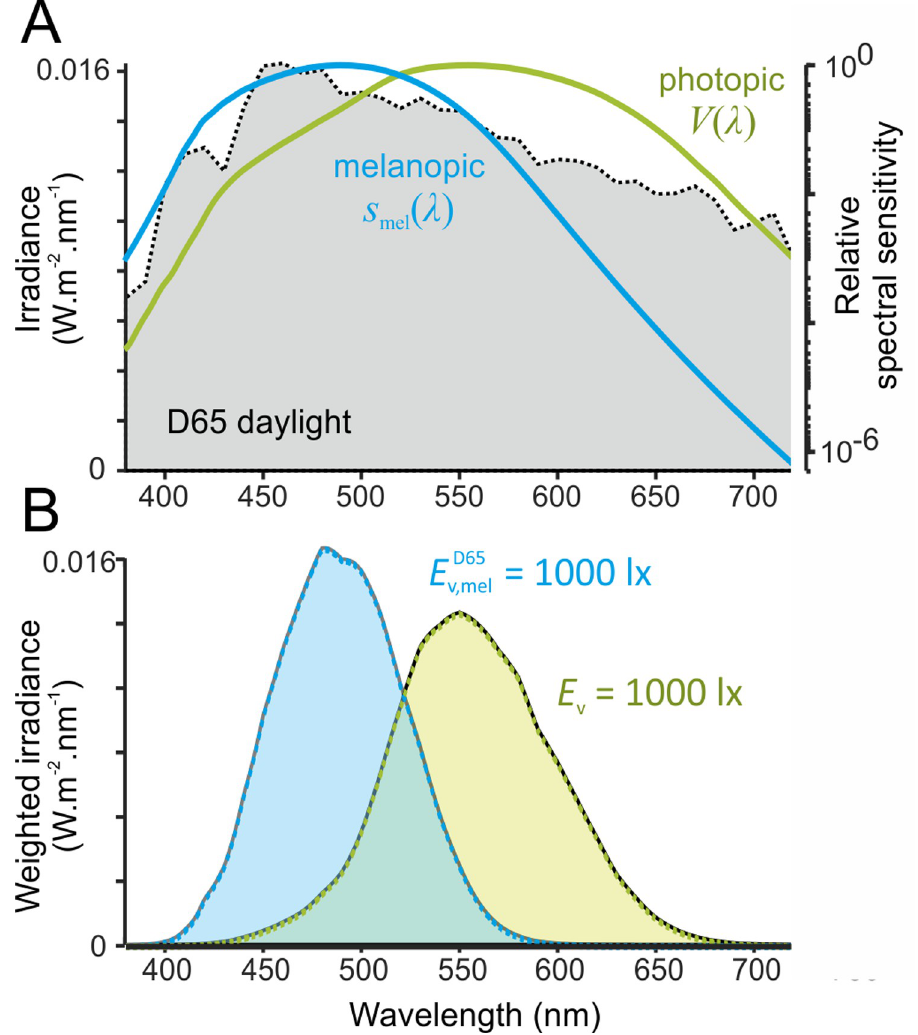
Fig 1. Differences in photopic and melanopic spectral sensitivity formalised in the SI-compliant system for quantifying ipRGC-influenced responses to light. Panel A illustrates the melanopic action spectrum ( s mel ( λ ) with peak sensitivity at 490 nm, following prereceptoral filtering appropriate for a 32-year-old observer) and the photopic (2˚ spectral luminous efficiency) function, V ( λ ), superimposed on the spectral power distribution of standard daylight (CIE illuminant D65 [142]). Spectral sensitivities are plotted in logarithmic coordinates. Panel B illustrates the weighted spectral power distribution for spectrum in A multiplied by the photopic and melanopic efficiency functions at 1,000 lux for illuminance ( E v ) and melanopic EDI ( E D 65 ). Sensitivity curves in A are plotted from the tabulated v ; mel values provided in the CIE S026 standard [34], with weighted irradiance (plots in B and associated calculations) derived using the procedures described in detail therein. CIE, Commission Internationale de l’Eclairage; i AU : AbbreviationlistshavebeencompiledforthoseusedthroughoutFigs 1 (cid:0) 3 : Pleaseverifythatallentriesarecorrect : pRGC, intrinsically photosensitive retinal ganglion cell; melaponic EDI, melanopic equivalent daylight